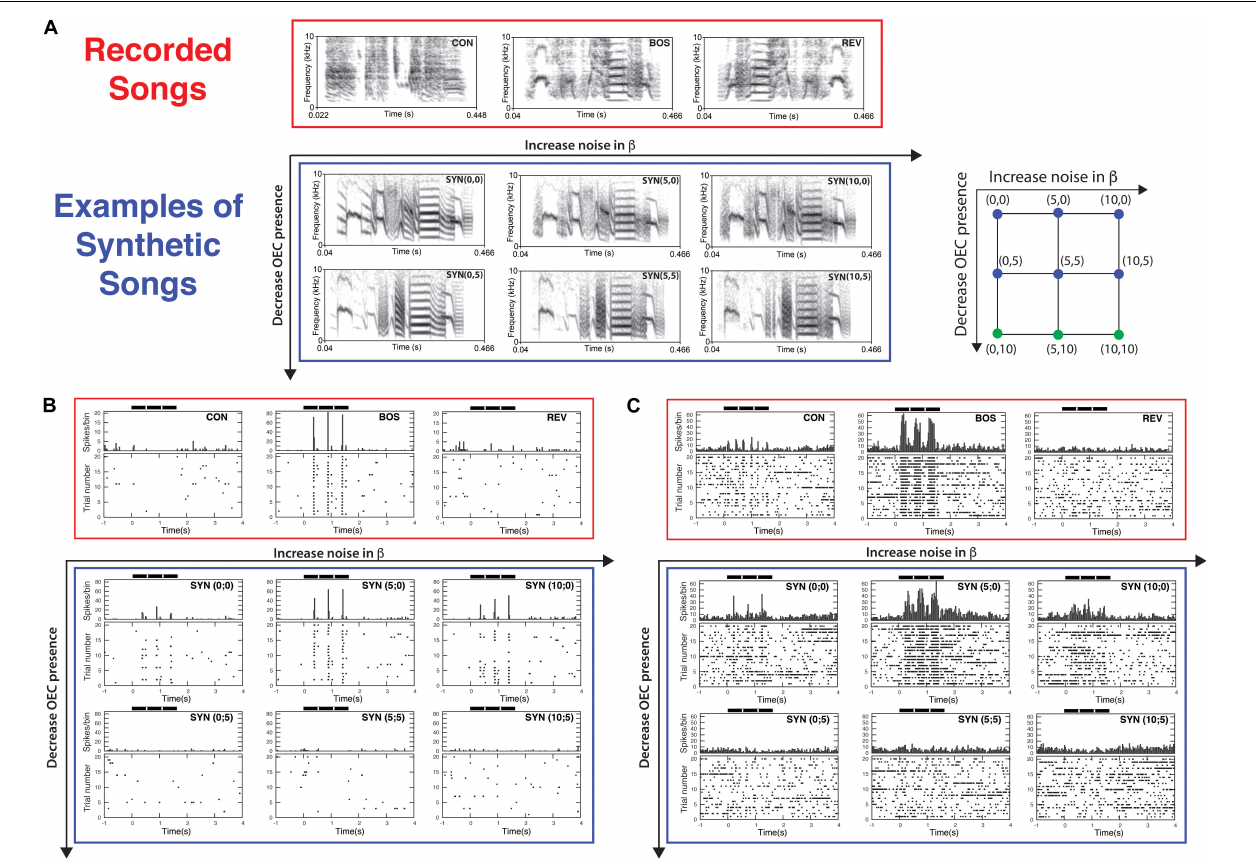
FIGURE 3 | Testing a low-dimensional model of vocal production and the relative importance of physiological-related parameters of the model. (A) Spectrograms of the recorded songs and synthetic songs used as auditory stimuli presented to sleeping birds. The recorded songs (BOS, REV, and CON) were used to test the neurons selectivity to BOS. A series of synthetic variants were generated (SYN, typically 9–12) using parameters from a grid. The indexes (a, b) in the legend SYN (a; b) refer to the level of noise in β and dissipation of the OEC resonator, respectively. These synthetic songs variants are represented as blue dots in the grid of the right panel. (B) Example of a raster plot and histogram of a phasic neuron response to the presentation of the auditory stimuli shown in (A) . The timing of the three repeated motifs that were presented is indicated by the bold horizontal lines. (C) Same as (B) but showing a recording of a tonic neuron. Adapted from Amador et al.